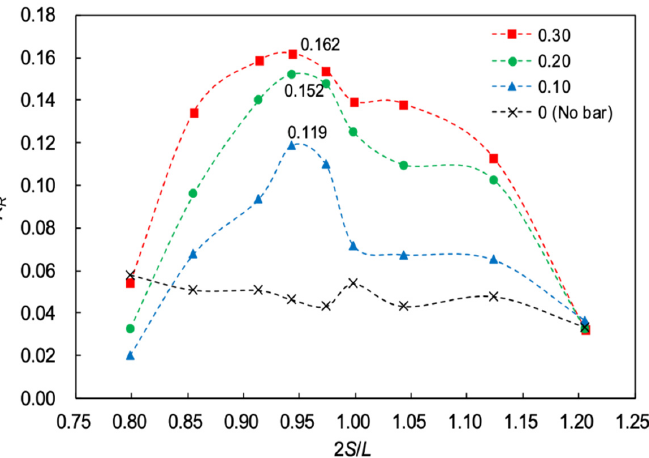
Figure 11. Influence of the relative width B / S on Bragg resonant reflection, rectangle, N = 4, φ = 68.85%, S = 1.0 m, h = 0.25 m, and H = 0.04 m.